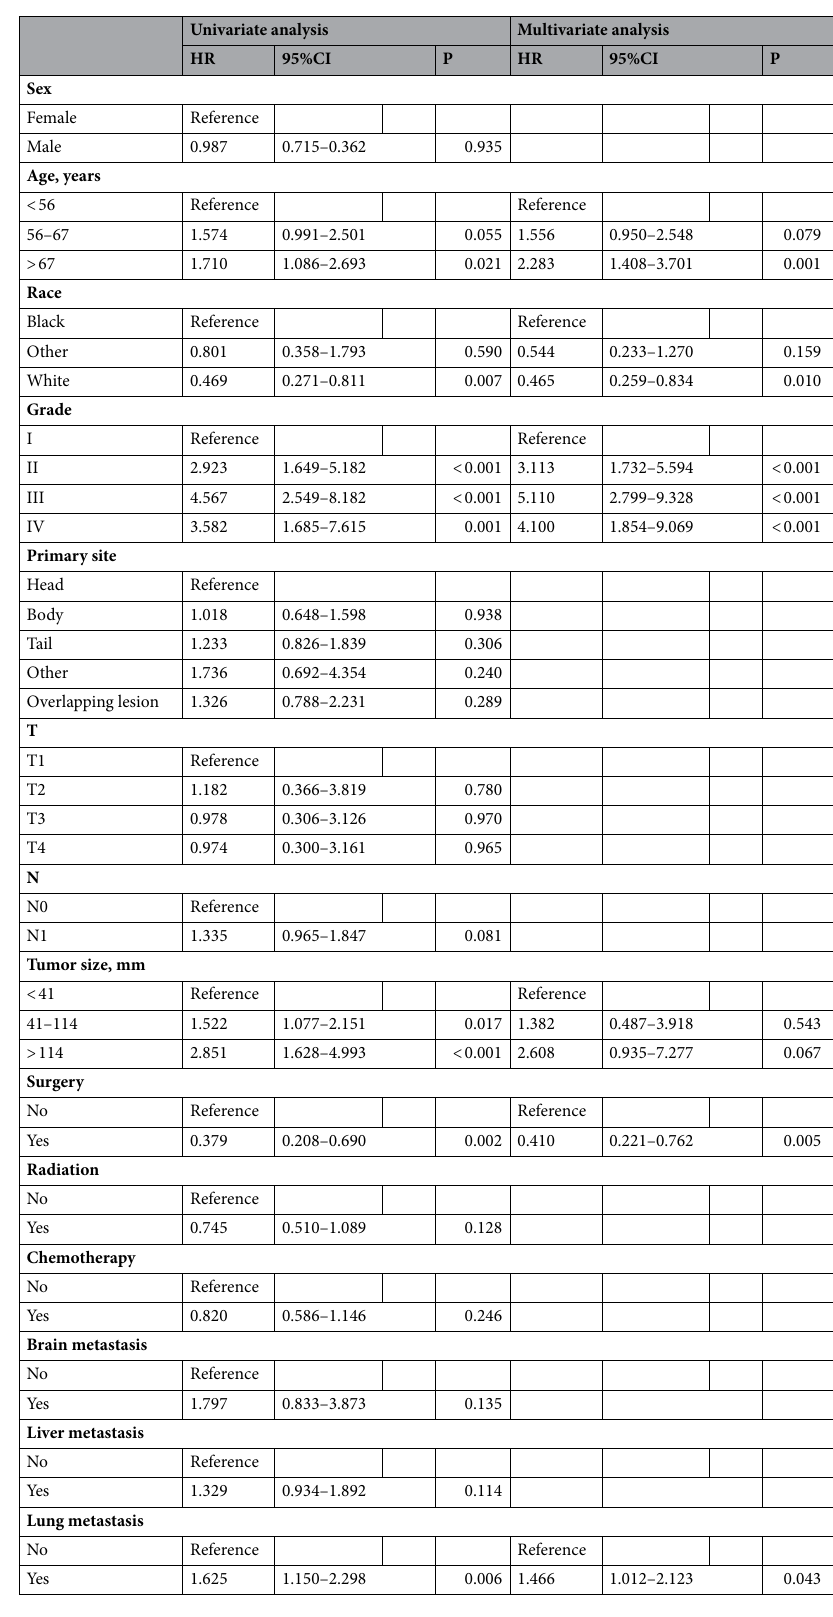
Table 4. Univariate and multivariate Cox analyses of PC patients with BM. HR Hazard ratio, CI Confidence interval, BM Bone metastasis, PC Pancreatic